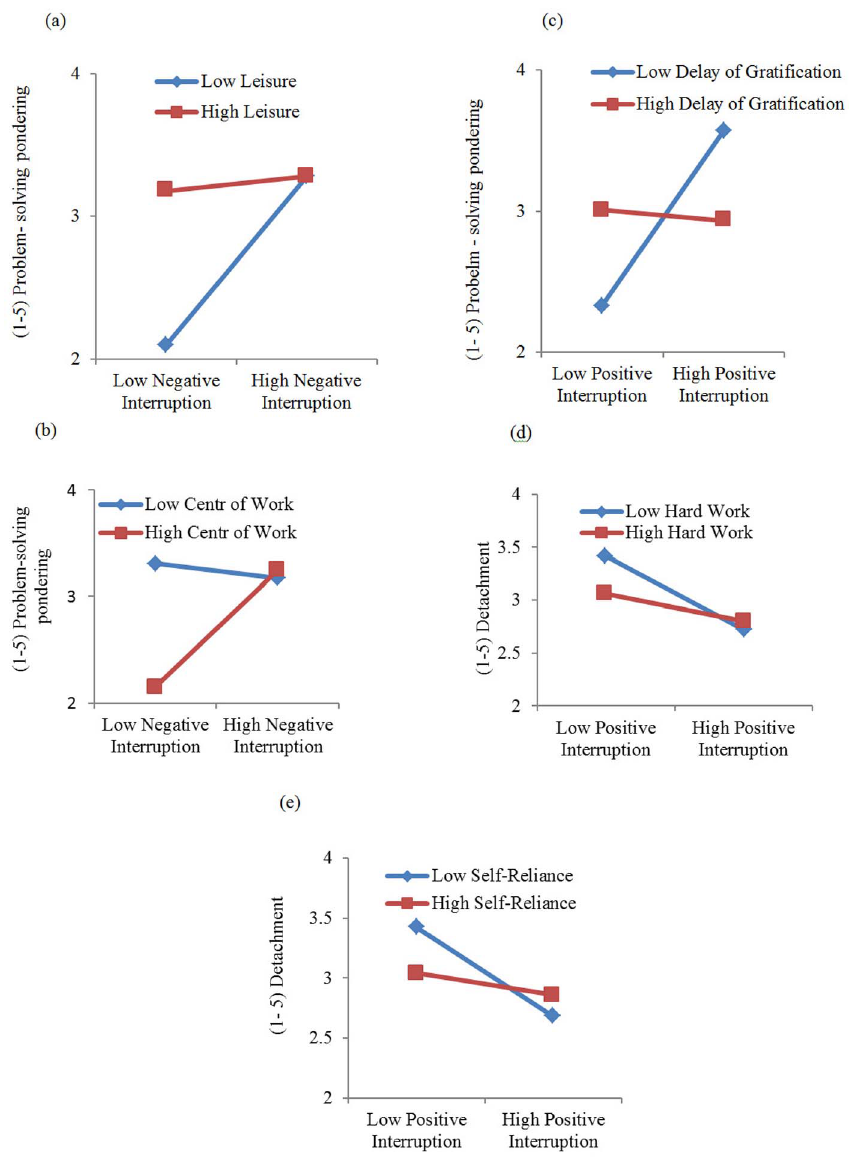
Figure 2. The relationships between work interruption and problem-solving pondering; and work interruption and detachment. (a). The relationship between work interruption and problem-solving pondering as a function of belief in leisure. (b): The relationship between work interruption and problem-solving pondering as a function of belief in centrality of work. (c): The relationship between work interruption and problem-solving pondering as a function of belief in delay of gratification. (d): The relationship between work interruption and detachment as a function of belief in hard work. (e): The relationship between work interruption and detachment as a function of belief in Self-reliance.